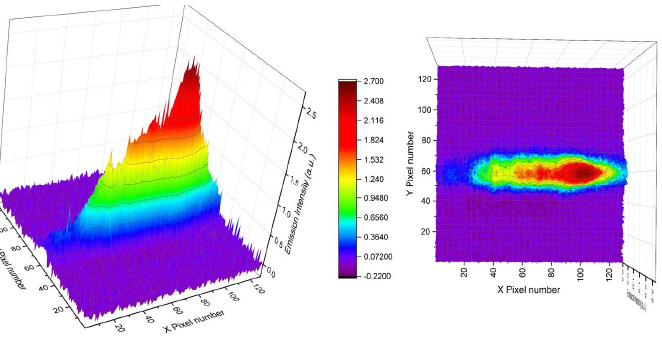
Figure 12. Calibration-corrected single-shot 2 − D LWIR LIBS spectrum of KCl. Next, we measured the LWIR LIBS emissions from acetaminophen sample tablets using the current collection optics setup and the PhaseTech 2-D array detector. The operation parameters and setups were mostly the same as previous studies using the linear MCT array detector. The only difference is that the linear array detector is replaced with the PhaseTech 2-D MCT array detector. This 2-D IR array detector has lower dark counts than the linear MCT array we currently employed. Therefore, the integration time of the 2-D LWIR LIBS measurement was set to be 200 µs to capture long lifetime LWIR LIBS molecular emissions. The whole 2-D image of the IR emissions from single-shot laser-in- duced plasma generated on the surfaces of the acetaminophen samples with a 20 µs delay and 200 µs integration window is plotted in Figure 13.